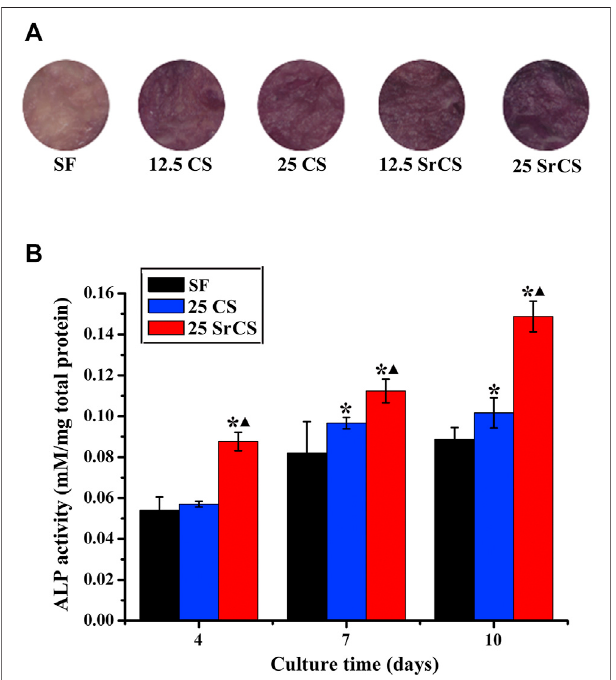
FIGURE7| ALPactivityanalysis. (A) ALPstainingofrBMSCsseededon differentmaterials(SF:SF,12.5CS:12.5 wt%CS/SF,25CS:25 wt%CS/SF, 12.5 SrCS: 12.5 wt% SrCS/SF, 25 SrCS: 25 wt% SrCS/SF) for 7 days. (B) ALP staining of rBMSCs seeded on different materials (SF: SF, CS/SF: 25 wt% CS/SF, SrCS/SF: 25 wt% SrCS/SF) for 4, 7, and 10 days. * p < 0.05 indicates the other groups vs. the SF group, and ▲ p < 0.05 indicates the 25 SrCS group vs. the other groups.